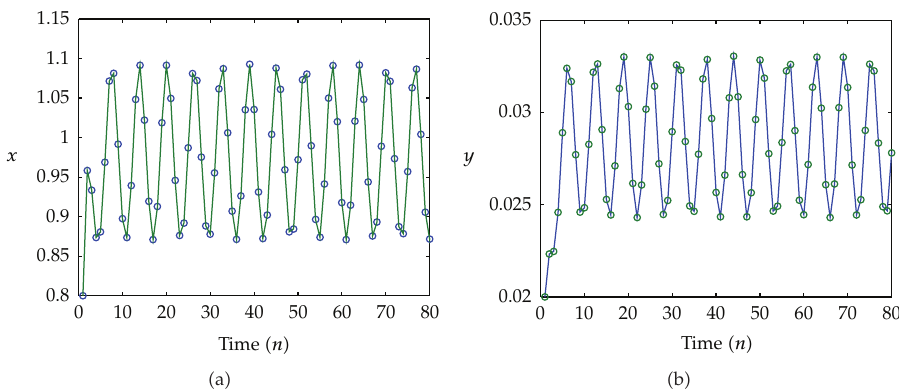
Figure 1: Dynamics behavior of system (cid:4) 4.1 (cid:5) with initial condition (cid:4) x (cid:4) 0 (cid:5) ,y (cid:4) 0 (cid:5)(cid:5) (cid:8) (cid:4) 0 . 8 , 0 . 02 (cid:5) .